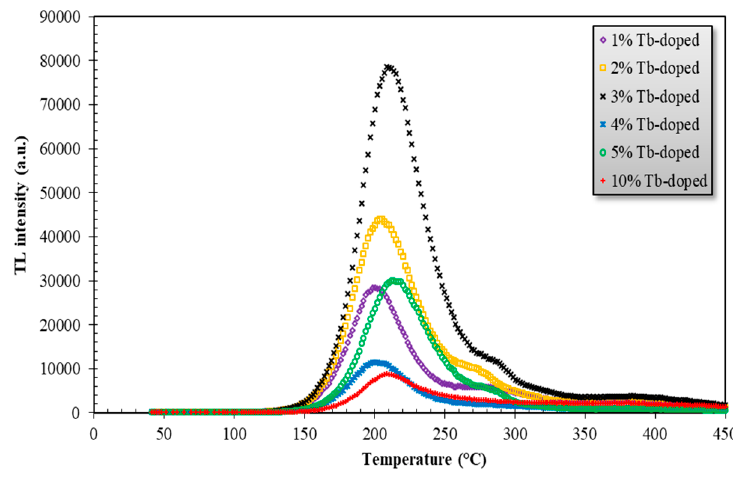
Figure 4. TL glow curves of ZnB 2 O 4 :Tb 3 + phosphors for a 30 Gy beta dose.